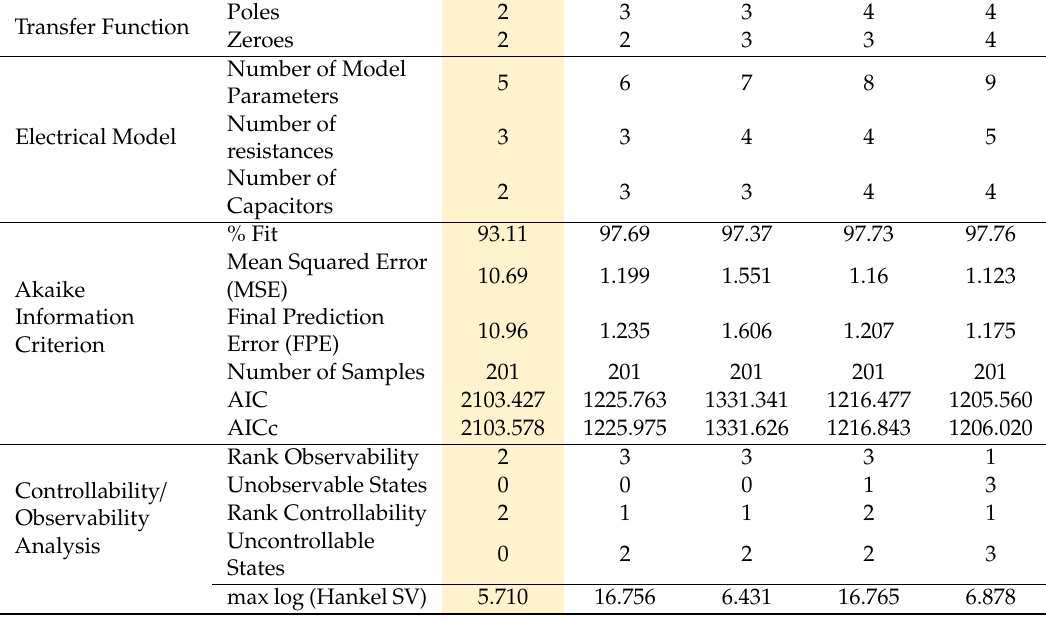
Table 5. Summary of model estimation for Trimethoprim / Sulfamethoxazole.